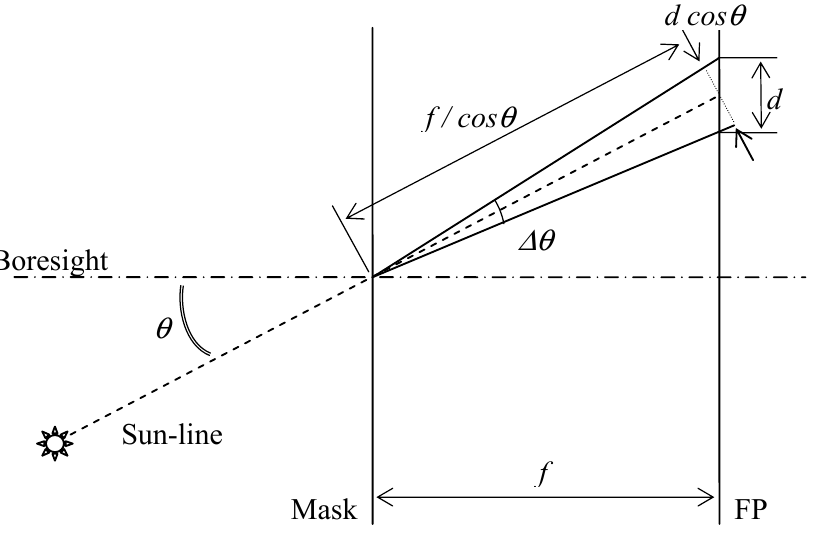
Figure 10. Simplified geometrical model for angular precision prediction.